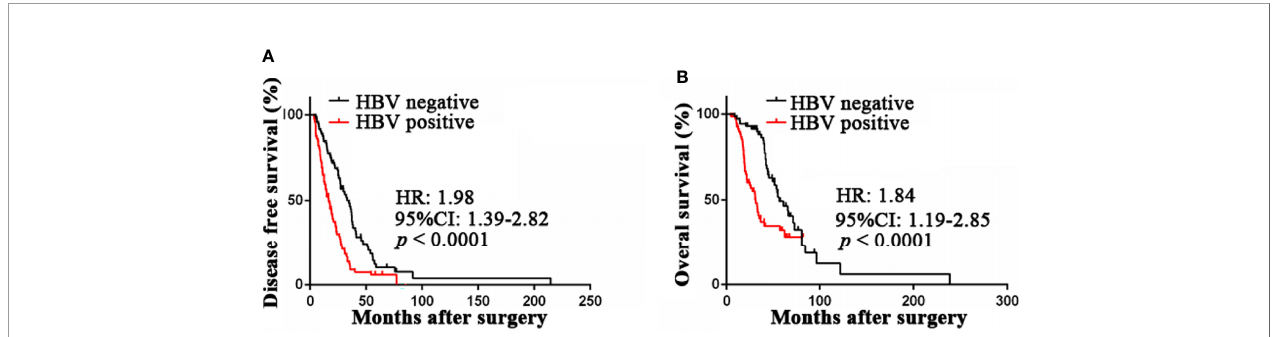
FIGURE 2 | Prognostic value of HBV infection in patients with gastric cancer. (A) HBV-positive patients was associated with poor disease-free survival compared with HBV-negative patients by Kaplan-Meier curves analysis. (B) HBV-positive patients was associated with poor overall survival compared with HBV-negative patients by Kaplan-Meier curves analysis. HBV, hepatitis B virus; HBV-positive, positive for HBsAg or anti-HBs, anti-HBe, and anti-HBc; HBV-negative, negative for HBsAg, HBeAg, anti-HBe, anti-HBs, and anti-HBc.